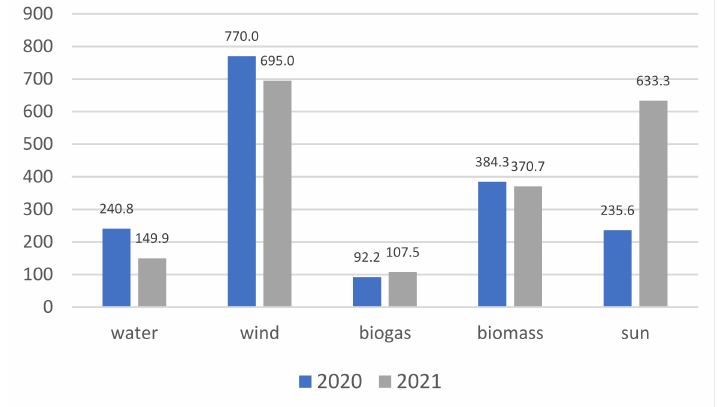
Figure 18. Electricity production from RES in GWh. Data from June 2020 and 2021. Source: own elaboration based on